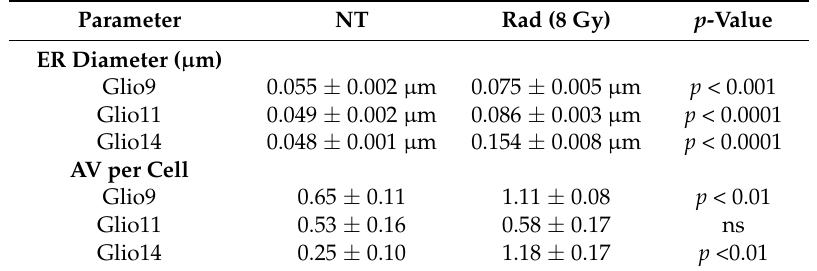
Figure 2. Radiation induces autophagosome formation and activation of unfolded protein response (UPR) in GSCs. ( A ) Transmission electron microscopy (TEM) analysis of Glio9, Glio11, and Glio14 comparing ultrastructural responses in non-treated lines and cells exposed to 8 Gy of radiation. Endoplasmic reticulum (ER, blue arrows) and autophagosomes (red asterisks) are highlighted. Five images from two independent studies were analyzed. Scale bar: 0.5 µm. ( B ) Quantitative analysis of ER luminal diameter, as a surrogate marker for ER stress, and autophagic vesicles per cell using TEM images. Results are representative averages of at least five images and are displayed as mean ± SEM. ** p < 0.01, *** p < 0.001. Mann-Whitney test. ( C ) Western blot analysis for ER stress markers (GRP78, GRP94, CHOP) and autophagy markers (LC3, Beclin-1, p62) in Glio9 and Glio14 at 1 h and 48 h post Table 1. Measurements of ER diameter (microns) and autophagic vesicles per cell in Glioblastoma stem cell (GSCs) treated with 8 Gy radiation. Mann-Whitney test.